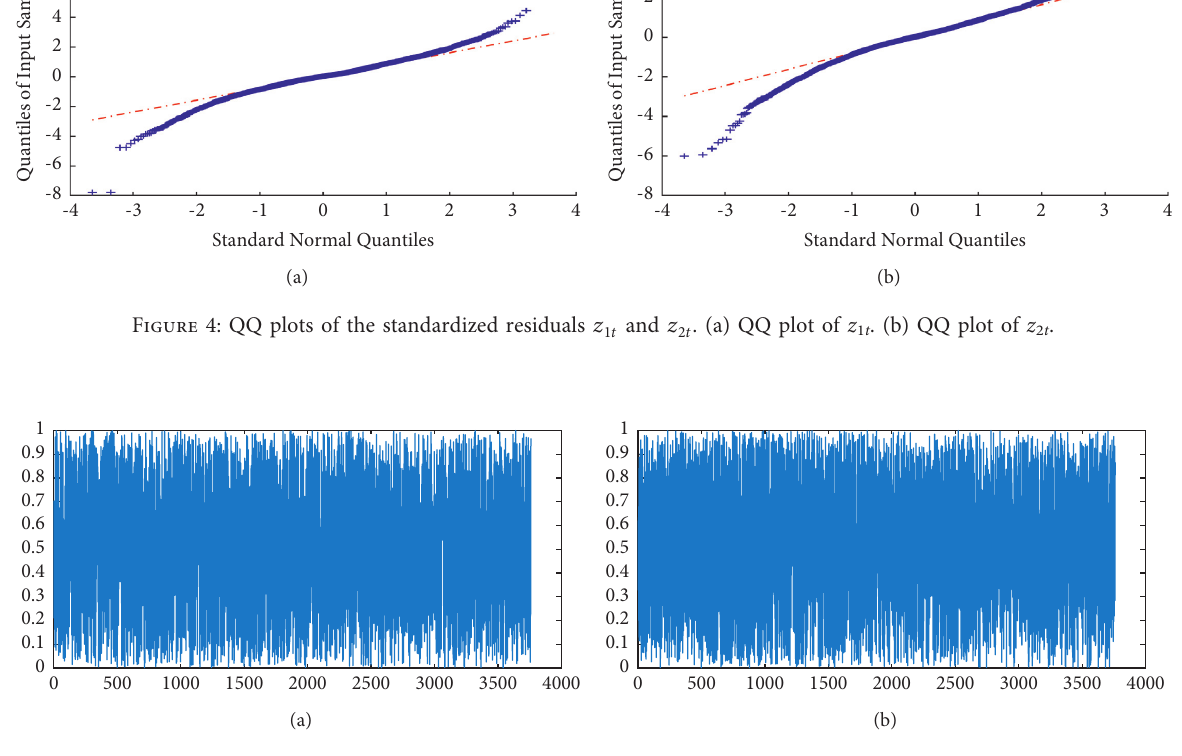
and z . (a) Marginal distribution of z 1 t ( u t ). (b) Marginal distribution of z 2 t ( v t ). 1 t 2 t